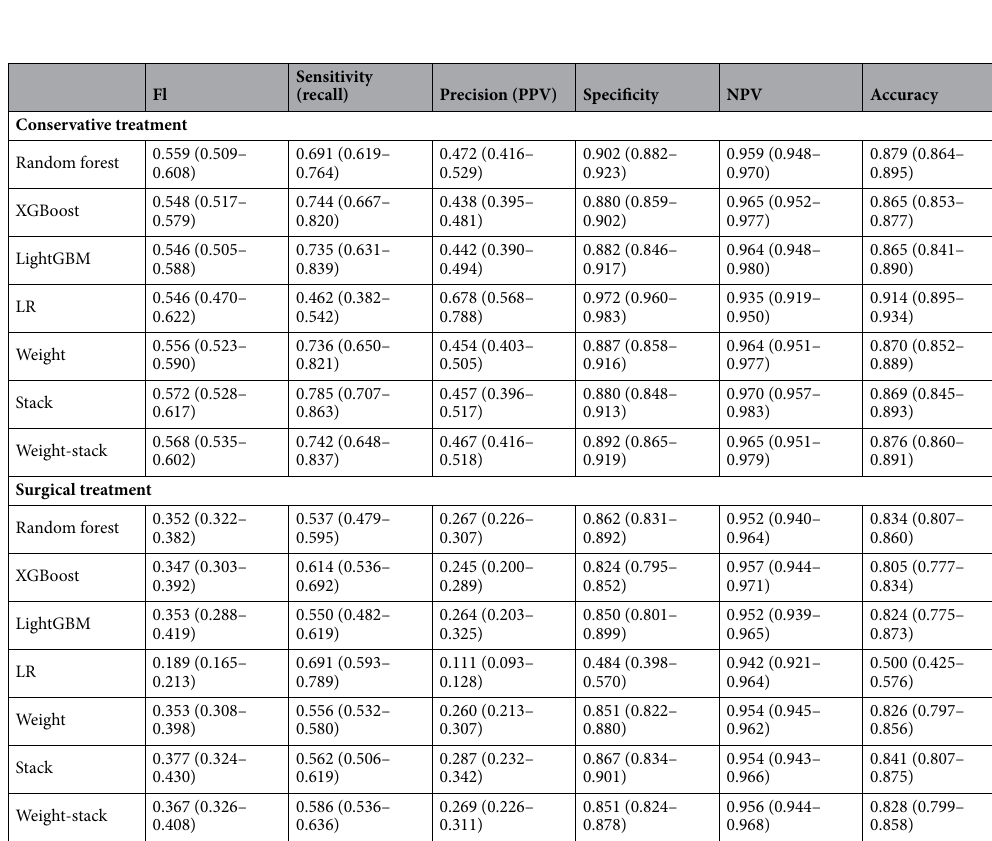
Table 2. Assessment metrics for the conservative versus surgical treatment groups on the testing set, including: F1, sensitivity (recall), precision (PPV), specificity, NPV and accuracy (from s.d.).